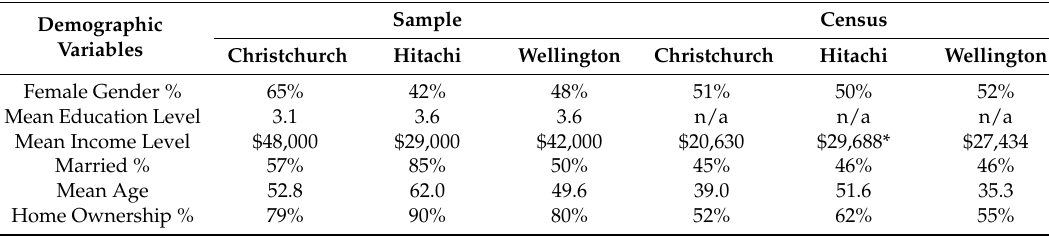
Table 1. Demographic characteristics of each site, compared to Census data. Table 1 . Demographic characteristics of each site, compared to Census data.